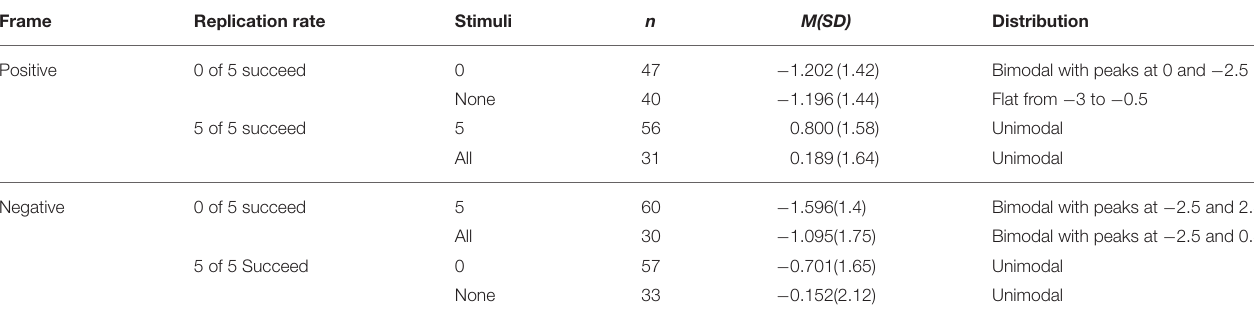
TABLE 7 | Descriptive statistics for the 0 of 5 and 5 of 5 replication rate conditions of Experiment 4.